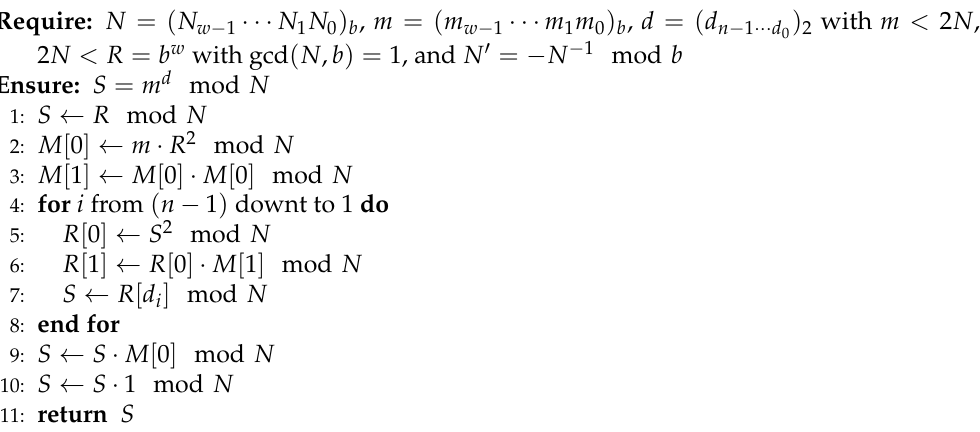
Algorithm 8 Modified Square-and-Multiply Always, Left to Right for